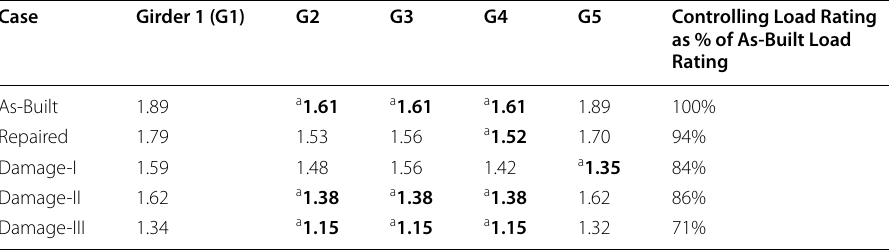
Table 4 Mean values for HL-93 operating load rating ( a controlling girder) Case